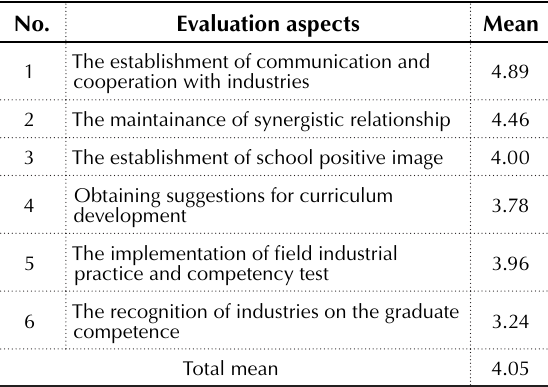
Table 3. The description of the program objectives achievement